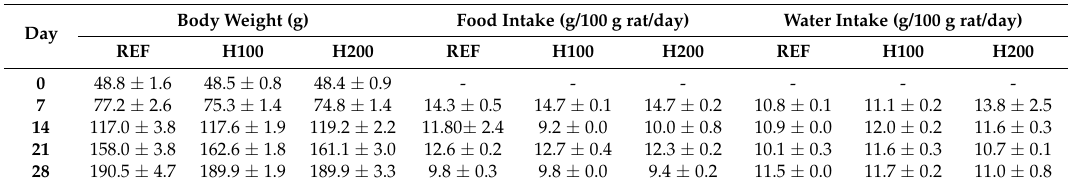
Table 2. Effect of hesperidin administration on body weight, food and water intake throughout the study. Body weight is expressed as mean ± standard error ( n = 6). Food and water intake data are expressed as mean ± standard error obtained from two cages (3 rats/cage).